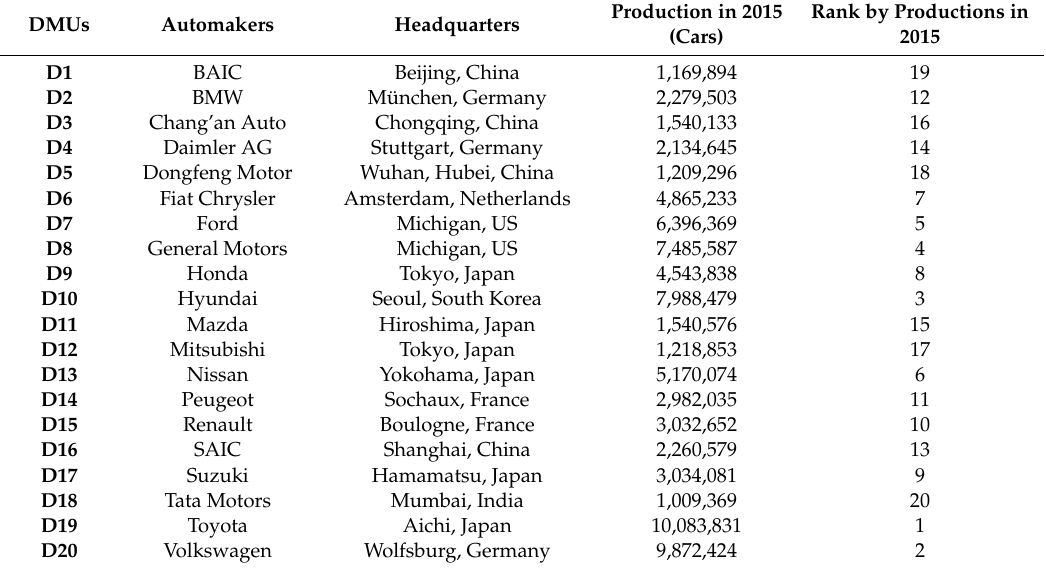
Table 1. List of 20 global automakers, according to the International Organization of Automobile Manufacturers (OICA)